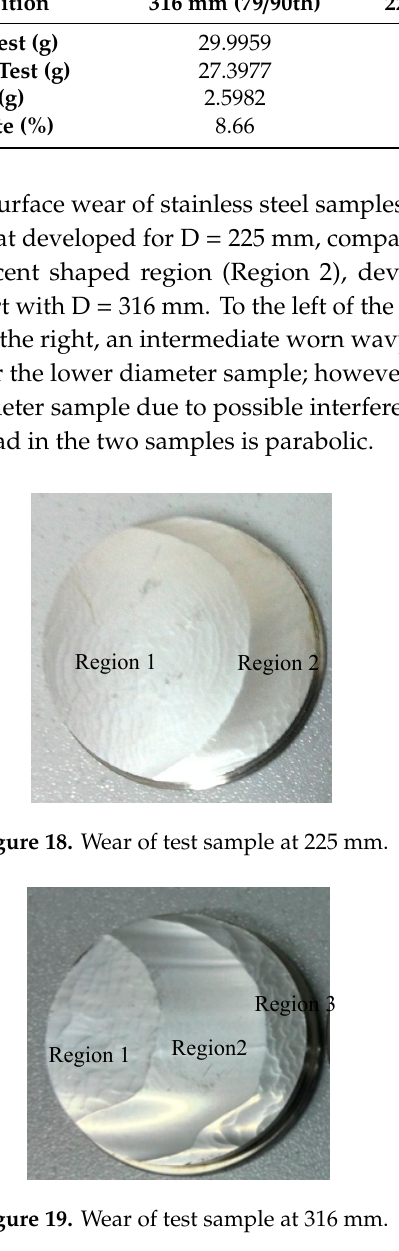
Table 2. Wear loss of stainless steel samples at the two positions.